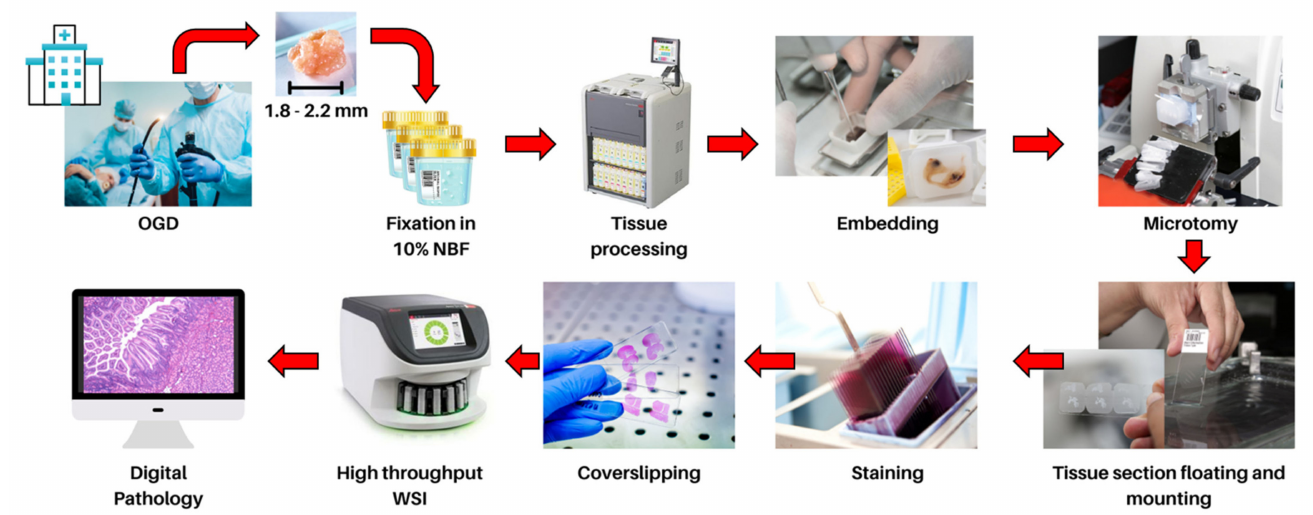
Figure 1. Tissues obtained by endoscopic biopsies are fixed in 10% neutral buffered formalin for 12–24 h. The fixed tissue undergoes dehydration, clearing and impregnation with molten paraffin wax by automatic tissue processors. The tissue is subsequently embedded in a paraffin wax block with proper orientation so tissue sections (3–5 µ m thick) can be cut with a microtome. The tissue section is manoeuvred onto a glass slide, stained and mounted with a coverslip to protect and preserve the section. The glass slide is digitized using high-throughput WSI scanners to create a virtual slide to allow for remote diagnosis and large-scale computational